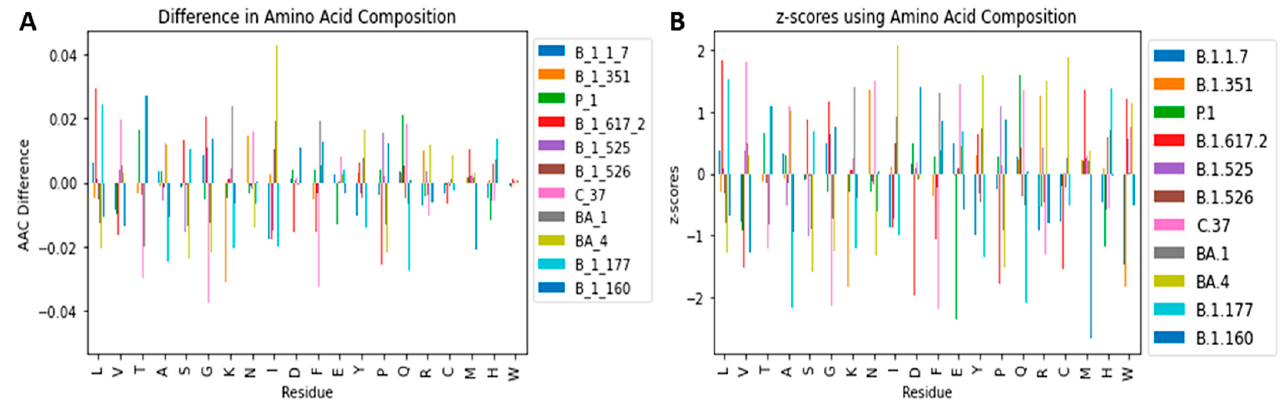
Figure 6. Bar plots showing the ( A ) difference between amino acid composition per variant and the mean amino acid composition and( B ) z-scores of the amino acid compositions belonging to each of the 11 SARS-CoV-2